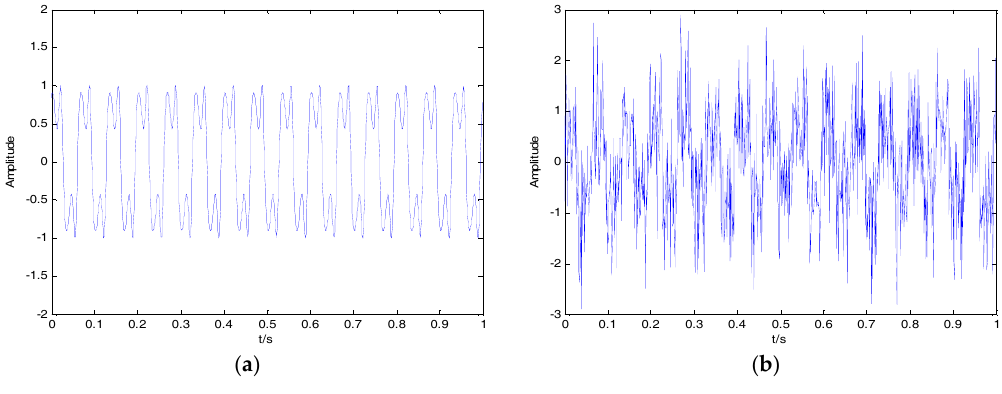
Figure 12. ( a ) The clear signal; ( b ) the noisy signal. Table 7. The SNRs after denoising.